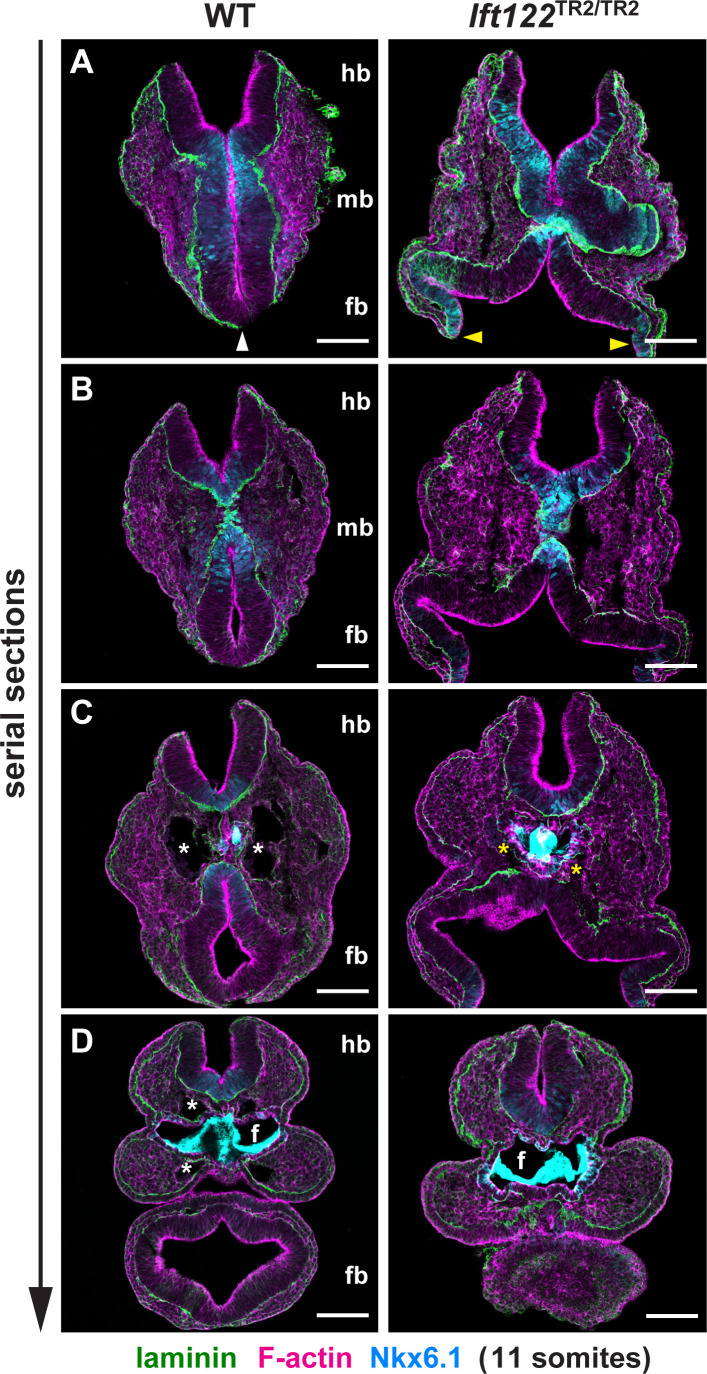
Disrupted cranial architecture in Ift122 mutants.(A–D) Serial transverse sections through a wild-type littermate control (WT) and an Ift122 mutant embryo at 11 somites. Phalloidin and laminin label the apical and basal surfaces of the neuroepithelium, respectively. Nkx6.1 labels ventral cells. In WT, the forebrain (fb, white arrowhead in top panel) is closed and the midbrain (mb) displays substantial neural fold elevation. In contrast, the Ift122 mutant shows a failure of forebrain closure (yellow arrowheads in top panel). Asterisks indicate the connection between the dorsal aorta and the first brachial arch artery. Nkx6.1 signal in the foregut pocket (f) is nonspecific trapping of secondary antibody. Bars, 100 μm.